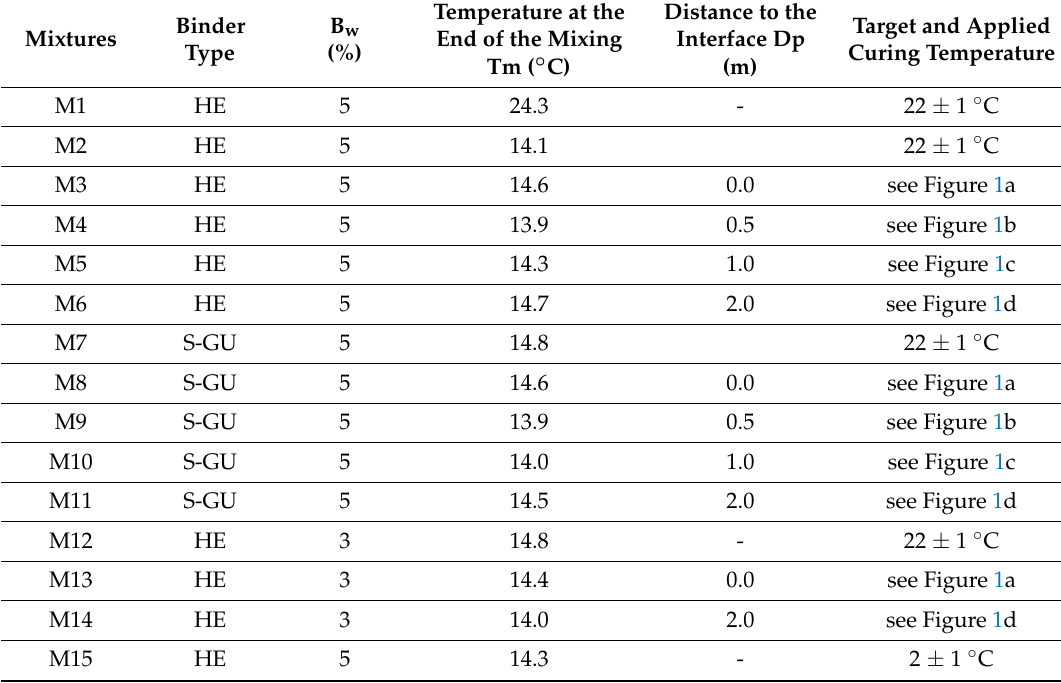
Table 1. Characteristics of the studied CPB